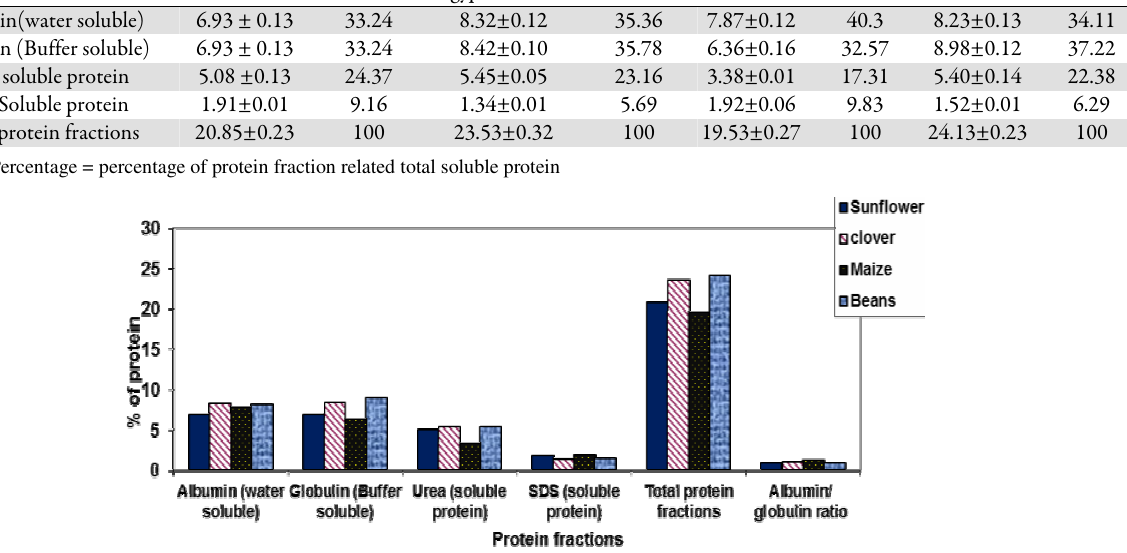
Fig. 1. Relative percentage of protein fractions of four pollen